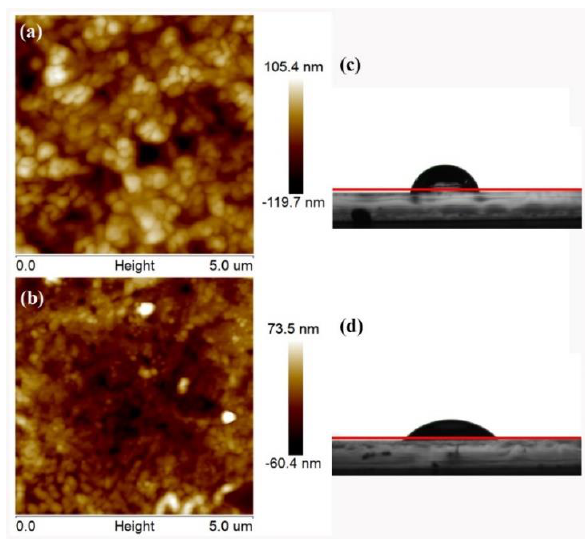
Figure 4. Two-dimensional (2D) tapping-mode atomic force microscopy (AFM) height ( a ) ITO/CsPbIBr 2 . ( b ) ITO/CsPbIBr 2 /CeO x . The water contact angle: ( c ) ITO/CsPbIBr 2 . ( d ) ITO /CsPbIBr 2 /CeO x